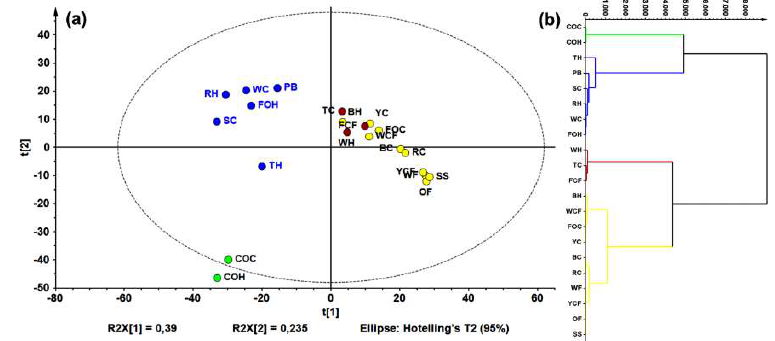
Figure 2. Principal component analysis (PCA) on liquid chromatography-mass spectrometry (LC-MS) data for all samples. ( a ) Principal component 1 (PC1) vs. PC2 score plot (R 2 Xcum = 0.625), colors according to hierarchical clustering analysis (HCA); and ( b ) HCA-derived dendrogram over PCA data.